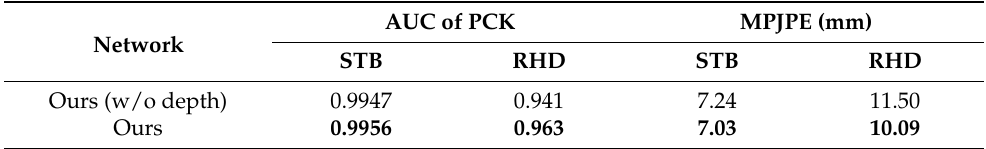
Figure 5. Comparative experiment of the effectiveness of the cross-fusion module on the RHD ( left ) and STB ( right ). ( a ) Describes the effectiveness of RGB image and depth map input in the RHD. ( b ) Describes the effectiveness of RGB image and depth map input in the STB. Table 3. Error analysis of input type effectiveness.